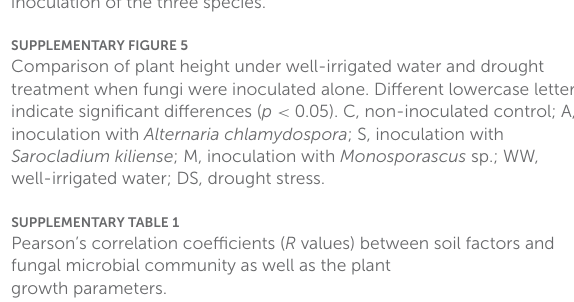
10.3389/fpls.2022.933738